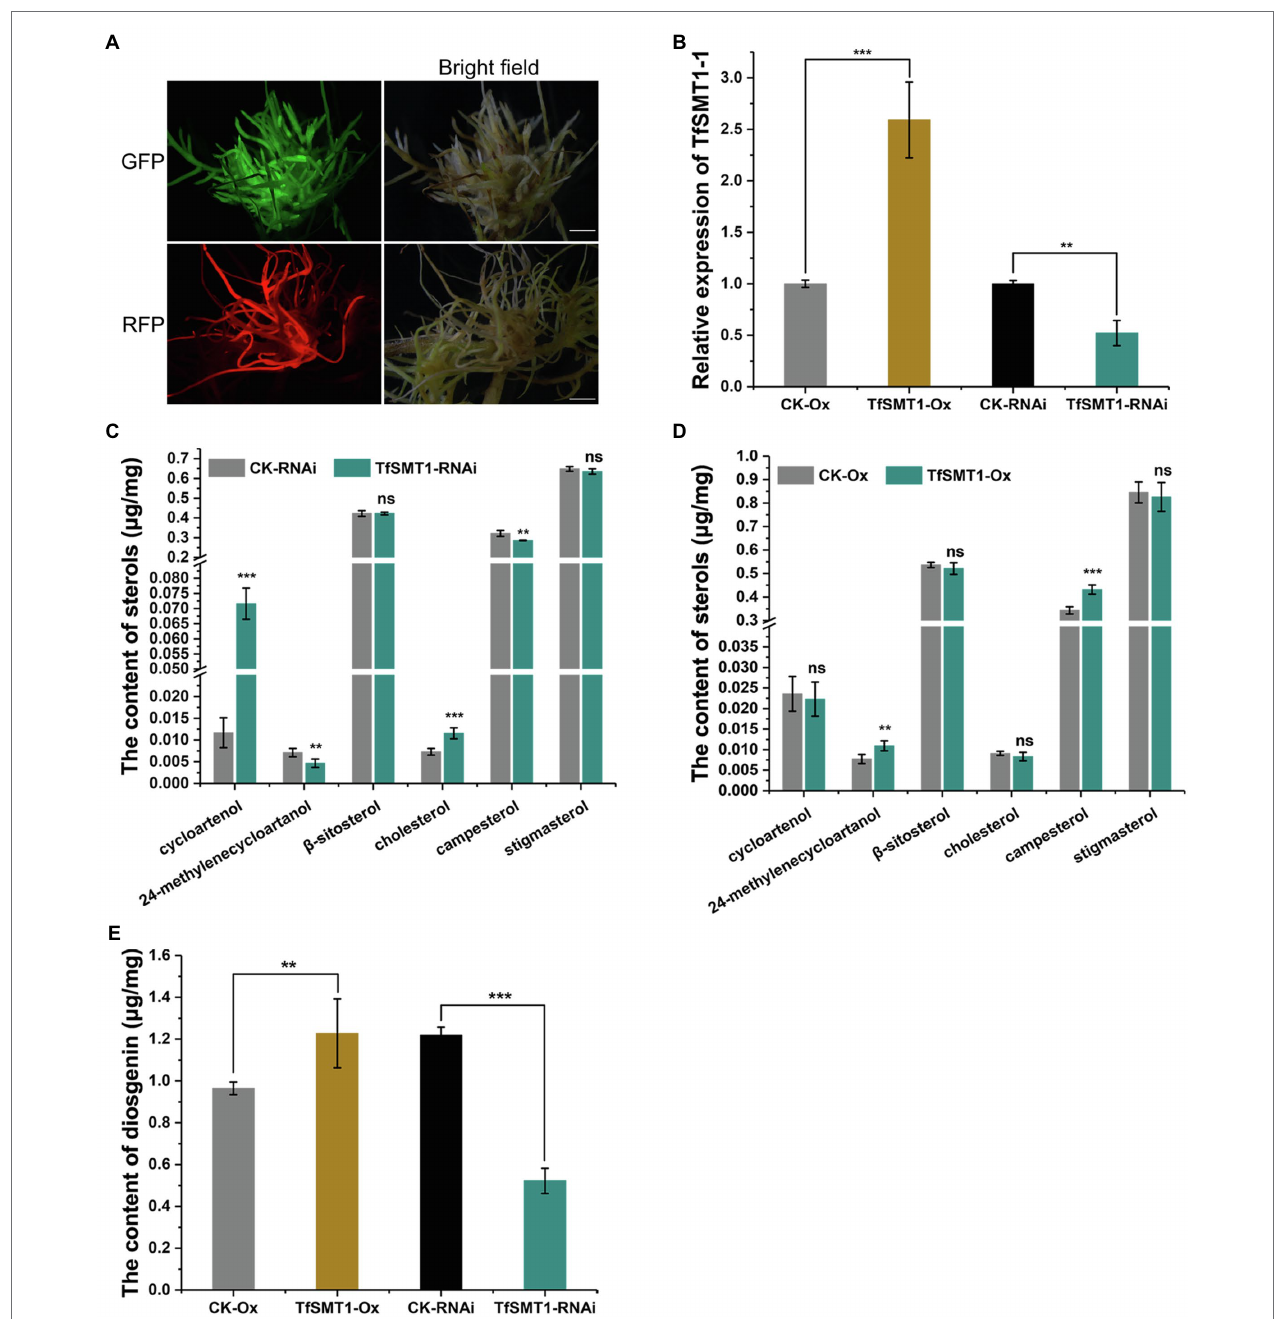
FIGURE 4 | The effects of overexpression and RNAi-based downregulation of TfSMT1-1 on accumulation of diosgenin and the targeted sterols in the transgenic T. foenum-graecum hairy roots. (A) , fluorescence signal was shown for the presence of the overexpression TfSMT1-Ox (GFP) and TfSMT1-RNAi (RFP) constructs in the T. foenum-graecum hairy roots. Scale bar = 1 cm. (B) , real-time PCR analysis of the TfSMT1-1 transcripts in the TsSMT1-Ox, TfSMT1-RNAi, and their corresponding empty vector control lines. (C) and (D) , the contents of the targeted sterols extracted from the hairy roots of TfSMT1-RNAi (C) and TfSMT1-Ox (D) lines in comparison with their corresponding controls. (E) , the effects of the overexpression and downregulation of TfSMT1-1 gene on diosgenin biosynthesis in the transgenic hairy roots. All these experiments were performed in three biological replicates. Asterisk indicates a significant difference by one-way ANOVA analysis (**p < 0.05; ***p < 0.01; and ns, not